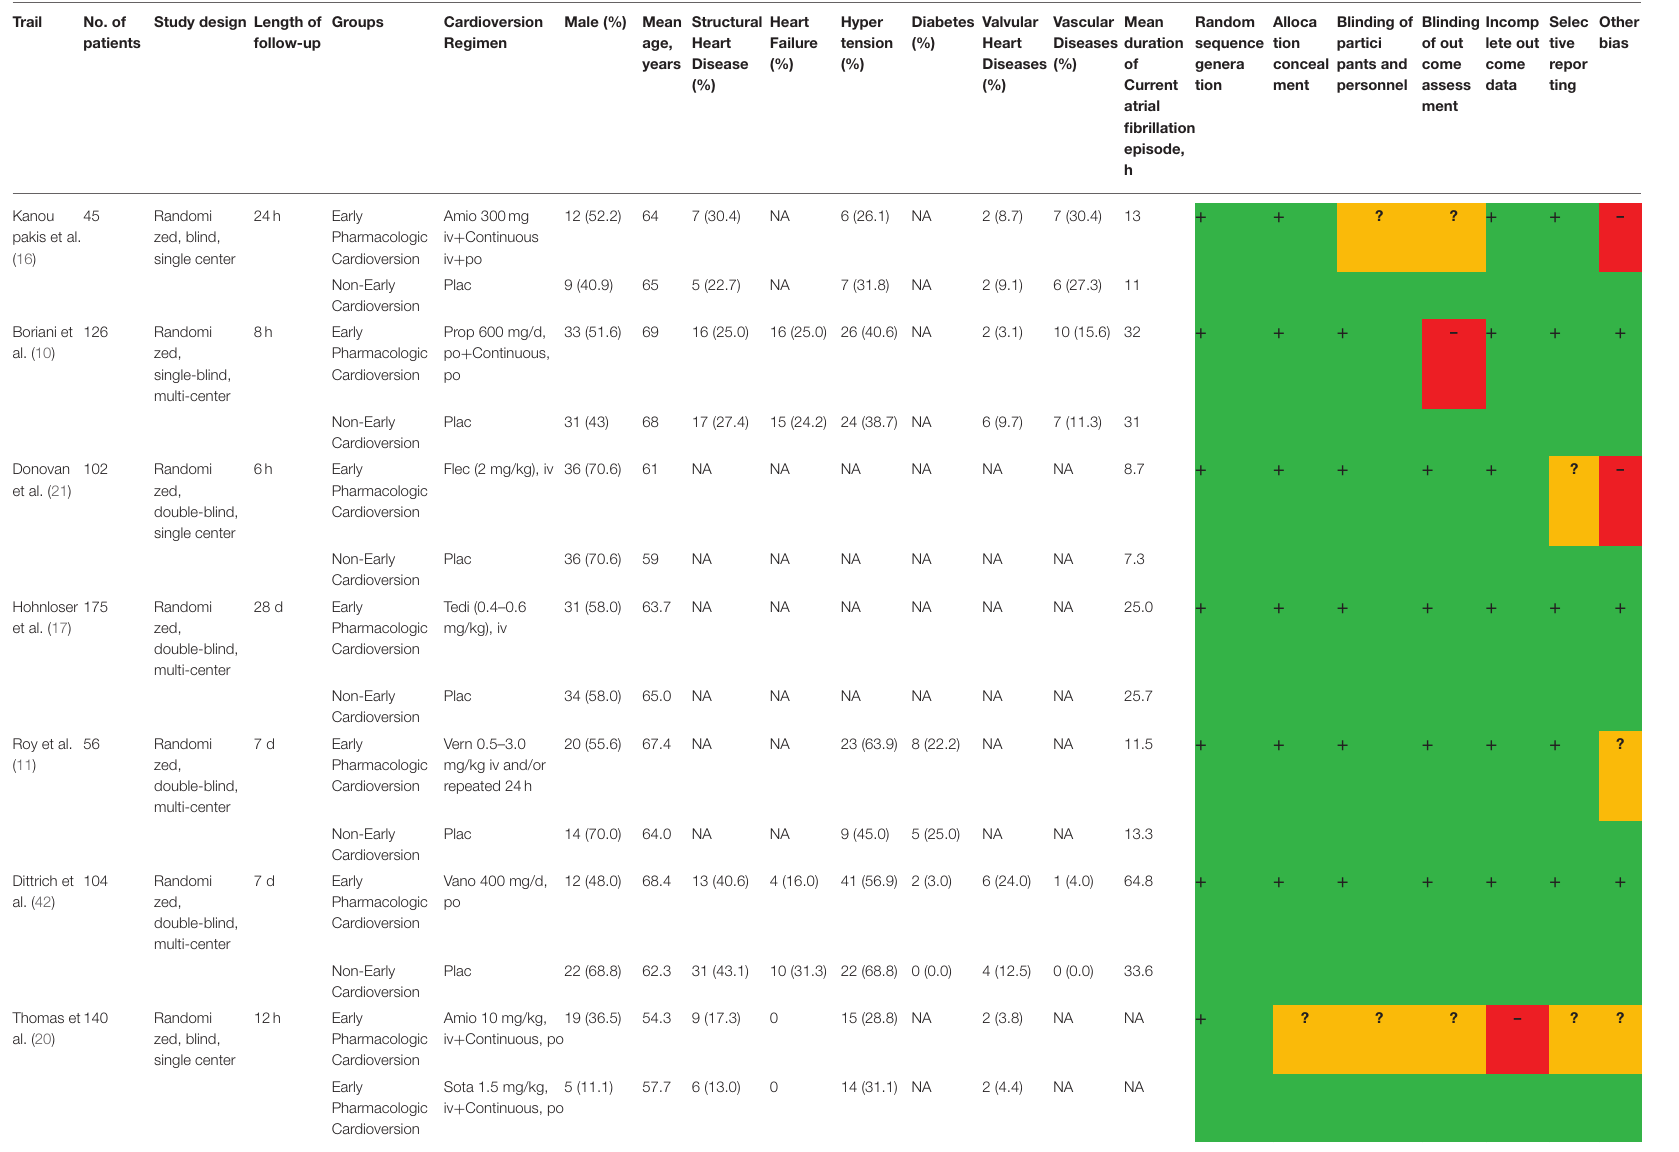
TABLE 1 | The characteristics and quality assessment in terms of Cochrane risk of bias assessment of included RCTs. Trail No. of Study design Length of Groups patients follow-up